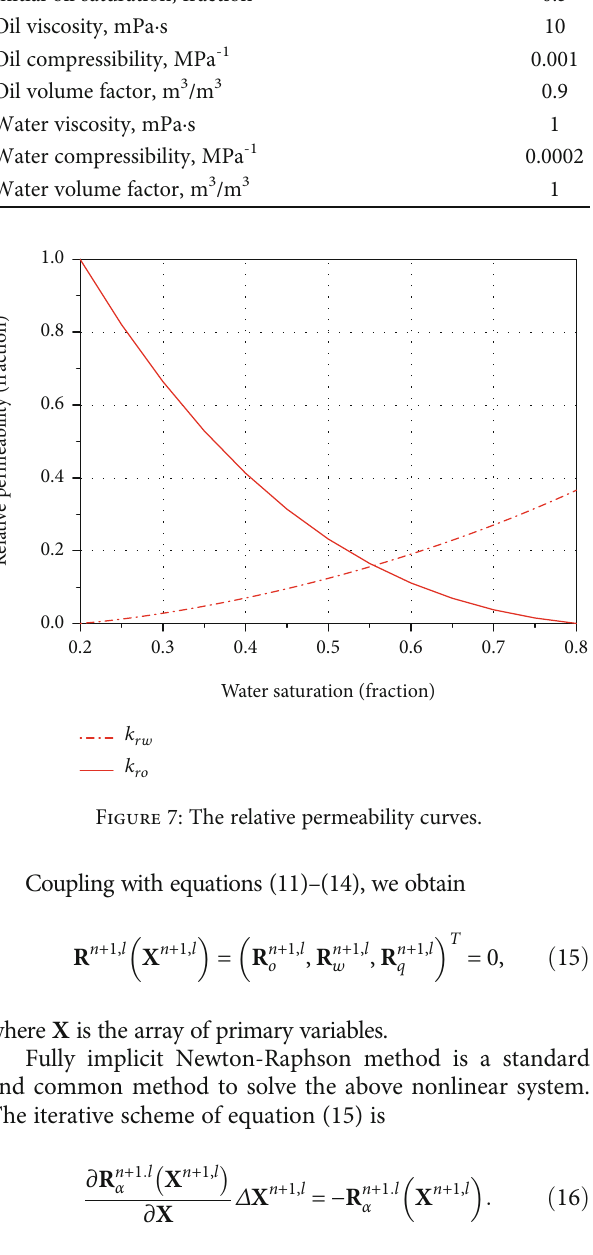
Figure 6: A reservoir with two wells. W1 is an injector; W2 is a producer. Well spacing between the two wells is 100 m. The fl ow rates of the two wells are both 100 m 3 /d.